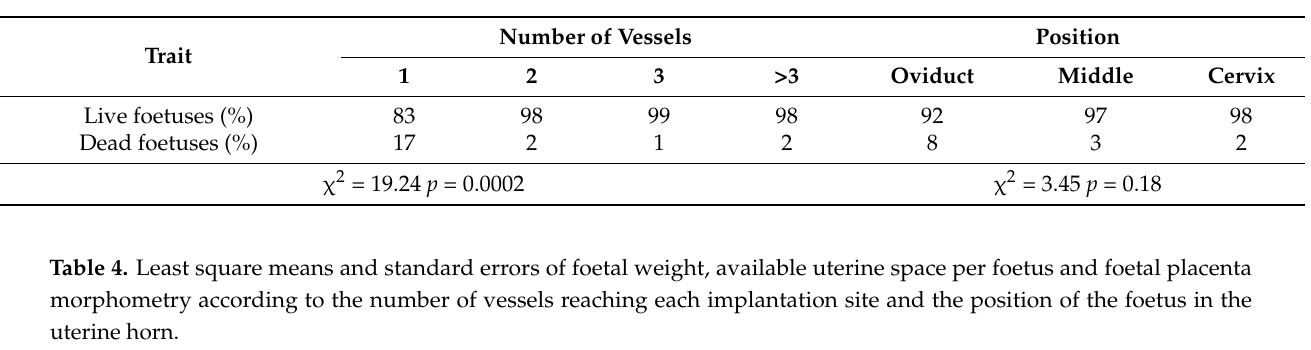
Table 3. Percentage of live and dead foetuses according to the number of vessels reaching the implantation site and the position of the foetus in the uterine horn.